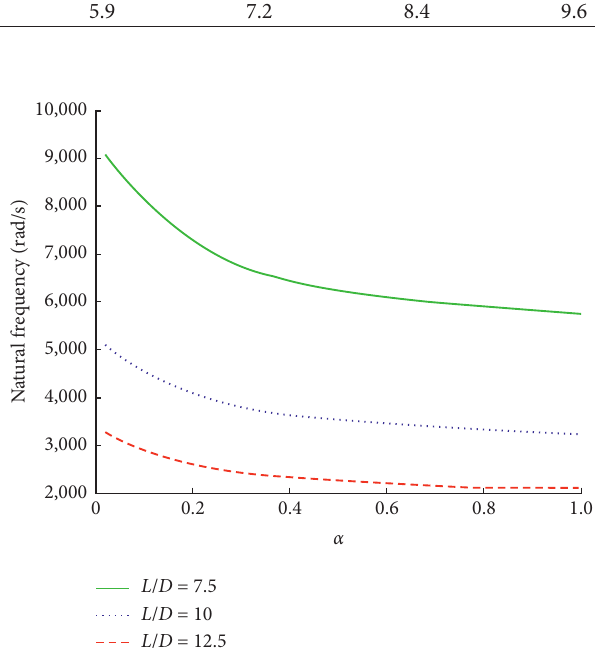
Figure 4: Natural frequency of the tapered composite boring bar with different L / D ratios.